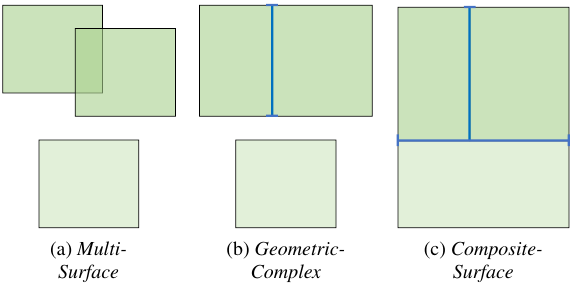
Figure 3. The topological differences in combined 2D geometries. Adapted from (Gr¨oger et al.,